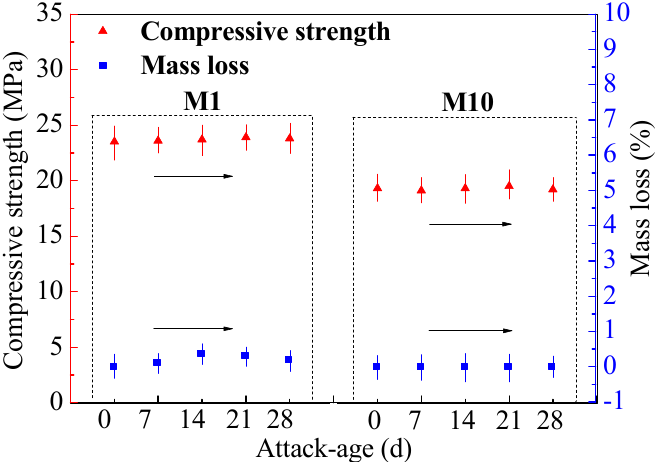
Figure 5. Compressive strength and mass loss of M1 and M10 (cured for 360 d), under Na 2 SO 4 -attack for 28 d. Table 7. The compressive strength and mass losses of M10 (cured for 360 d) and Ordinary Port-